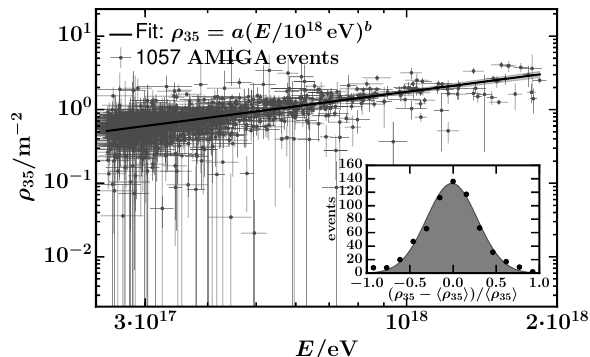
. . . Figure 9: Energy-normalized muon densities (cid:104) ρ 35 (cid:105) / ( E / 10 18 eV) as a function of E for AMIGA data compared to simula- tions with the EPOS-LHC (dashed) and QGSJ et II-04 (dotted) high-energy hadronic interaction models for both proton (red) and iron (blue) primaries. Mean muon densities for AMIGA in bins of energy are displayed by round mark- ers, error bars denote the statistical uncertainties. System- atic uncertainties are indicated by square brackets. The normalized fitted energy dependence ρ 35 ( E ) / ( E / 10 18 eV) is shown by a black solid line with a shaded band corre- sponding to the fit